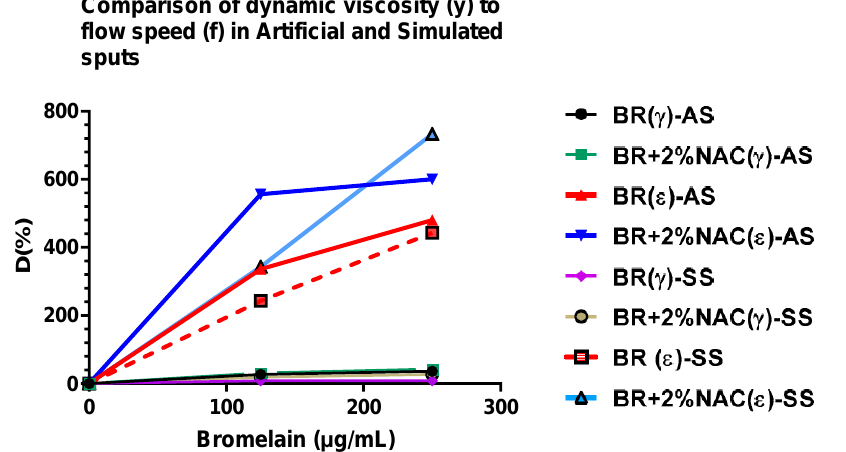
Figure 6. The relative differences in enhancement D (%) of the two parameters measured such as viscosity ( γ ) and flow speed ε in the artificial sputum (AS) and simulated sputum (SS), when treated with either bromelain (BR) 125 or 250 µ g/mL alone or in combination with NAC 20 mg/mL (BromAc). Viscosity changes in the different groups are amplified in flow speed, showing the effect of viscosity on the latter. Treatment with BromAc has a much higher effect on flow speed compared to treatment with bromelain alone. D = [(Treated − Untreated)/Untreated] × 100. Although with the addition of NAC 20 mg/mL to bromelain 125 and 250 µ g/mL in Table 6. Comparison of viscosity (γ) and f low speed (ε) between the two sputa models when treated artificial sputum, the decrease in viscosity was only 4–6 % compared to bromelain alone with bromelain 125 or 250 µg/mL and in combination with NAC 20 mg/mL. (from 31–42% to 27–36%, respectively), there was tremendous increase in flow speed ( ε ), D Value (%) indicating that small decreases (changes) in viscosity may affect clearance of the fluid by Artificial Sputa (AS) Simulated Sputa (SS) ciliary motion. The high BromAc concentration group indicates almost twice the reduction of pipette emptying time compared to the low BromAc group. This does not correlate with their respective viscosity ( γ ), which may indicate that high glycosylated mucin may affect the viscosity to a significant level. In simulated sputa, with the addition of NAC 20 mg/mL